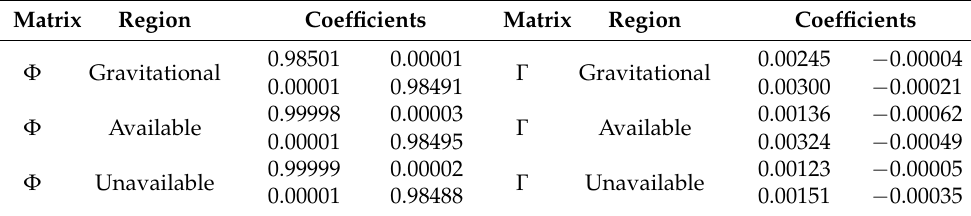
Figure 3. Soil moisture dynamics for the different regions, figure obtained from [9]. Over four weeks, irrigation, soil moisture, and reference evapotranspiration data were gathered at a sampling rate of 10 min, since, as suggested by [4], this represents, in practice, the minimum sampling time to capture the irrigation process dynamics. The obtained data was divided according to the soil moisture regions, and then coefficients values for Φ and Γ were identified using the estimation algorithm proposed by [9] to model the process dynamics. Table 1 shows the obtained coefficients for each irrigation area. Table 1. Identified coefficient values for state–space model matrices according to the soil moisture